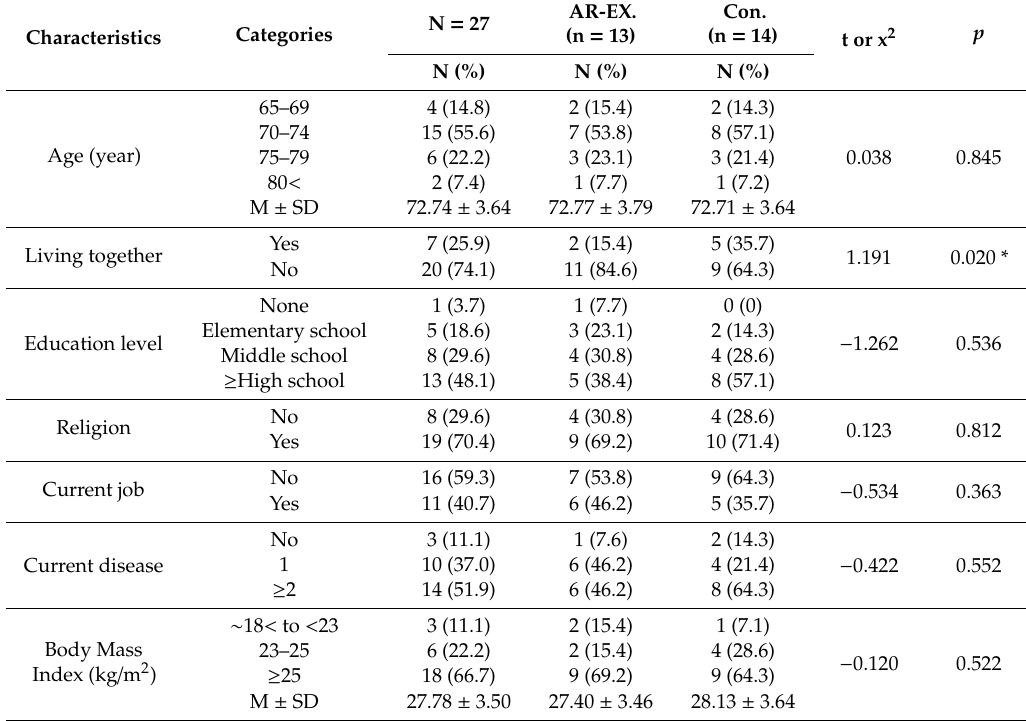
Table 1. Homogeneity of general characteristics between groups.